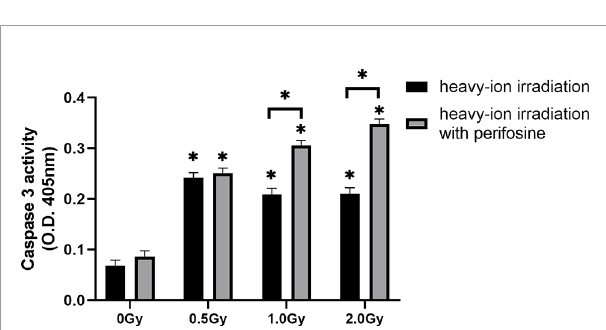
FIGURE 6 | After heavy-ion irradiation with or without perifosine, Caspase-3 activity in C6 cells was determined using a commercial Caspase-3 assay kit. * p < 0.05 vs. control or other